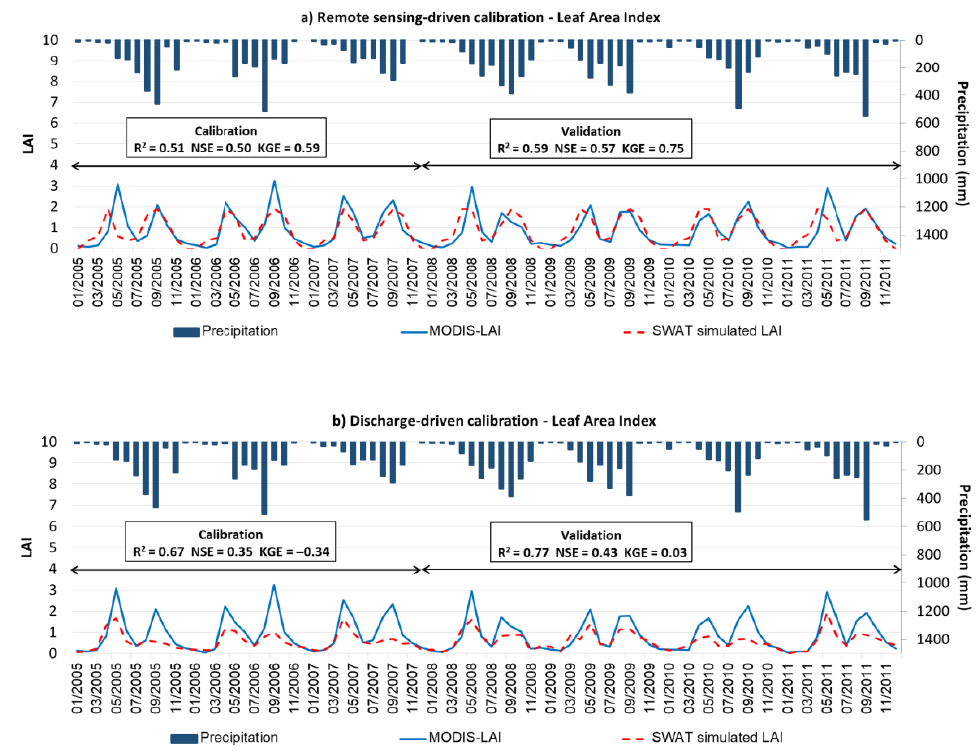
Figure 8. Determination of the LAI from MODIS and SWAT simulation for an HRU consisting of